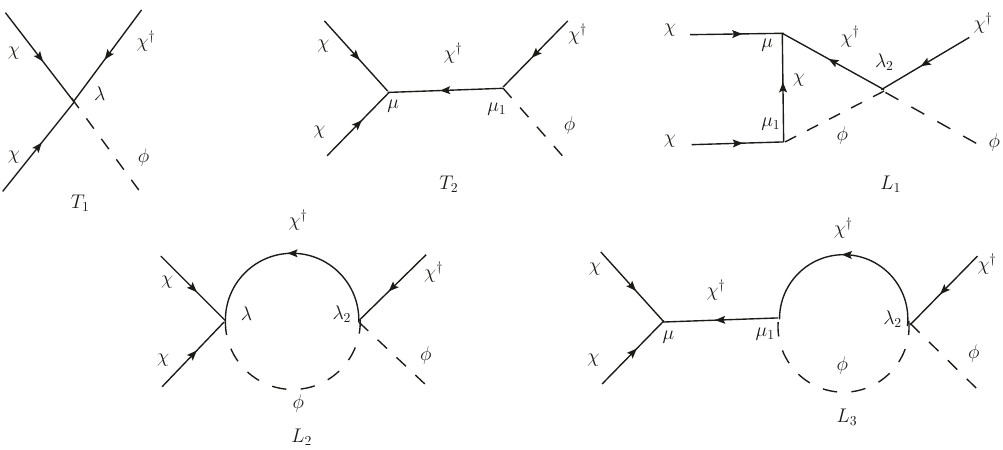
Figure 10 . Relevant 2 2 tree-level and one-loop Feynman diagrams for the semi-annihilation ! (cid:31) y (cid:30) process (cid:31)(cid:31) !